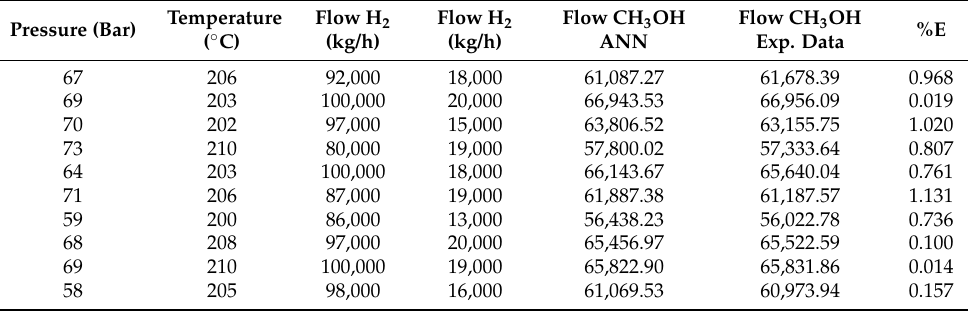
Table 11. Percentage error values between predictions (ANN) and experimental